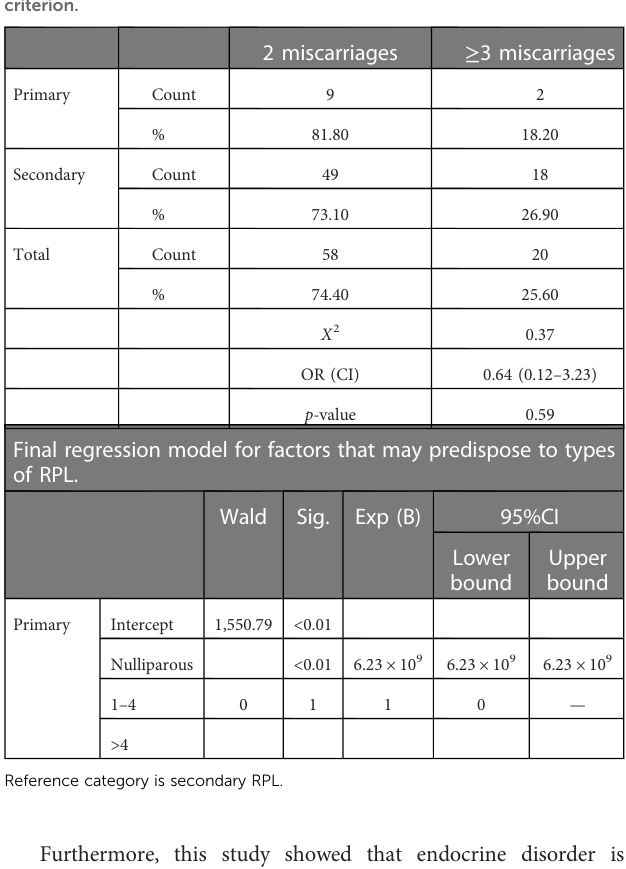
TABLE 9 Association between type of miscarriage and RPL classi fi cation criterion.